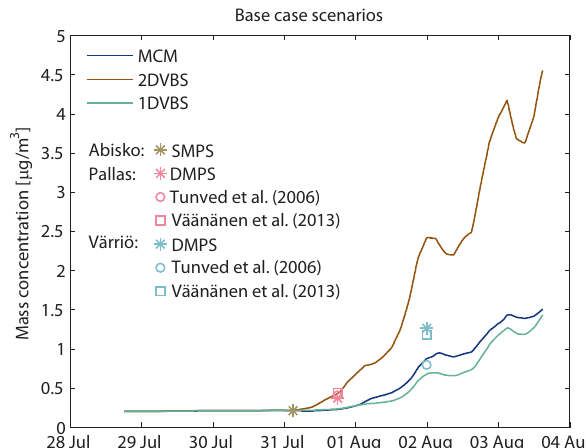
Figure 4. Modeled evolution of particle mass along the studied air- mass trajectory. The SMPS (scanning mobility particle sizer) and DMPS (differential mobility particle sizer) data points are the mea- sured size distribution at Abisko, Pallas and Värriö at the time the air mass passed. Also shown are estimated average mass concen- trations as functions of the time the air mass spent over land. The rings are based on measurement during the growing season between 1999 and 2004 (Tunved et al., 2006) and the squares are based on measurements between 2005 and 2007 (Väänänen et al.,